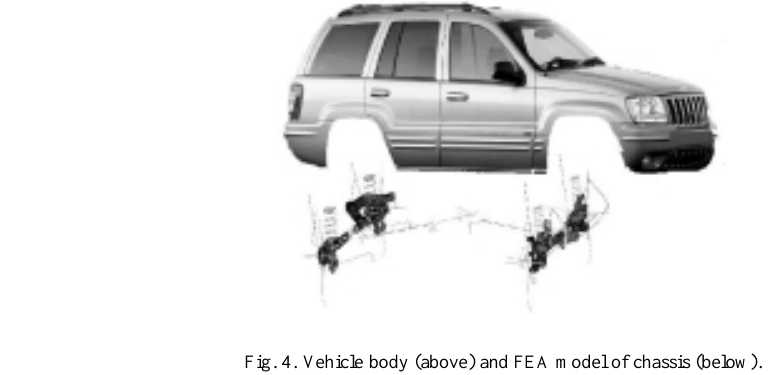
Fig. 4. Vehicle body (above) and FEA model of chassis